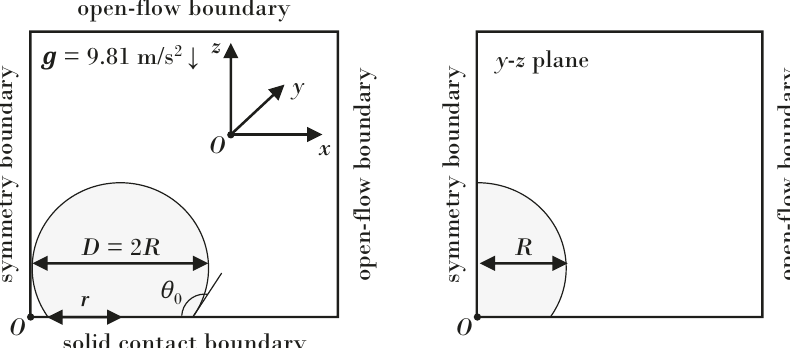
Fig. 2 3D computational domain for simulating binary sessile drop coalescence. Symmetry planes as indicated.